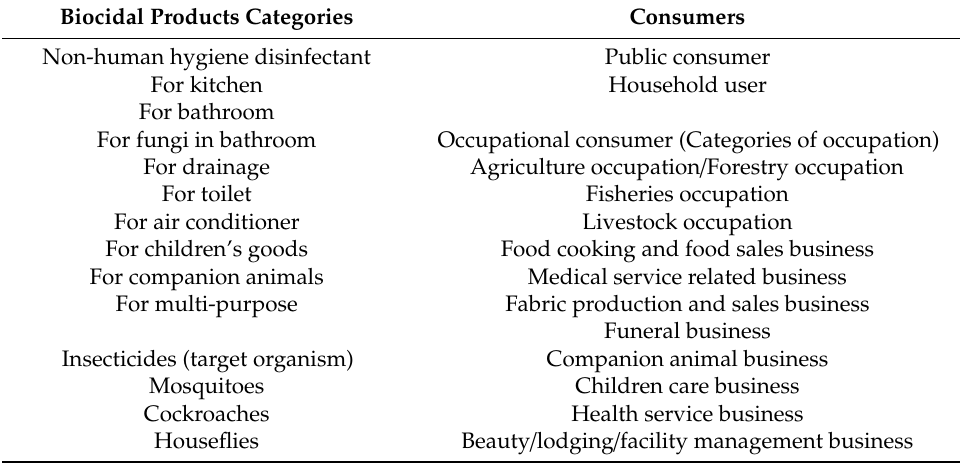
Table 1. Categories of studied biocidal product and product